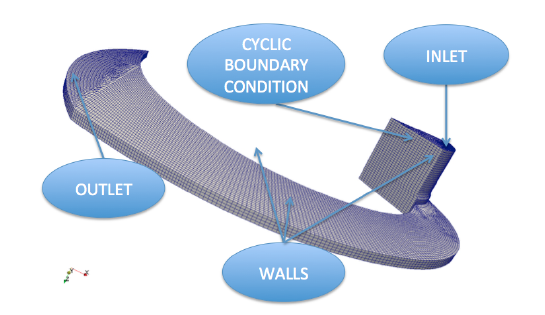
Figure 2: Centrifugal pump channel discretization and boundaries.